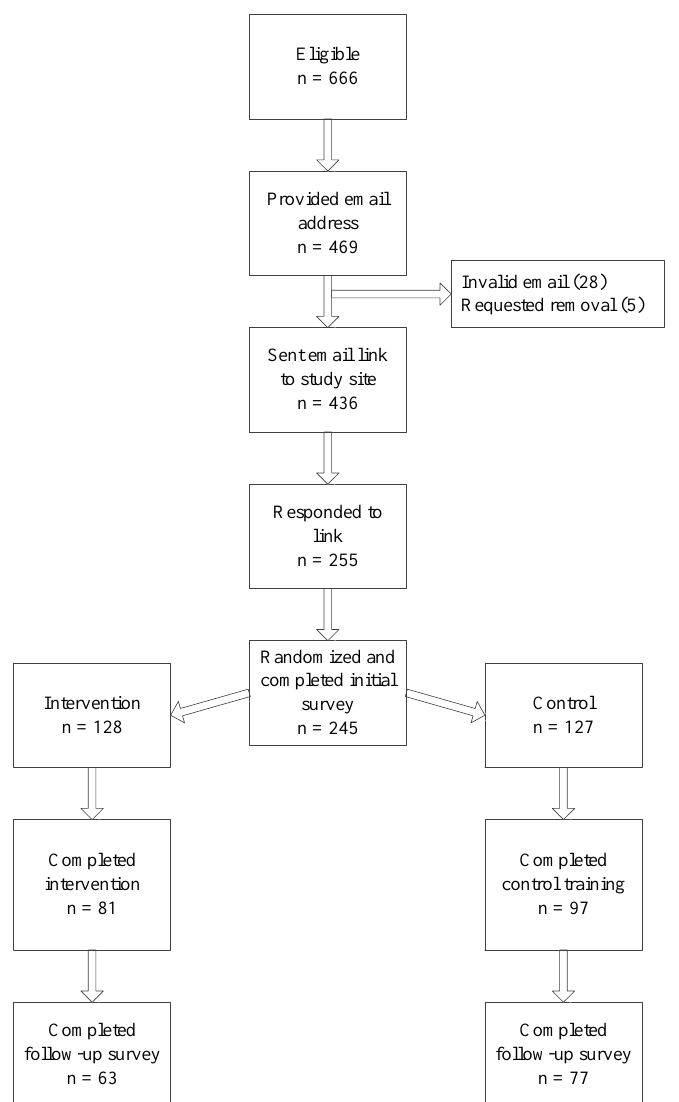
Figure 1. Participant recruitment and retention (data from those completing the intervention and control training were included in the analyses ( n = 178)).